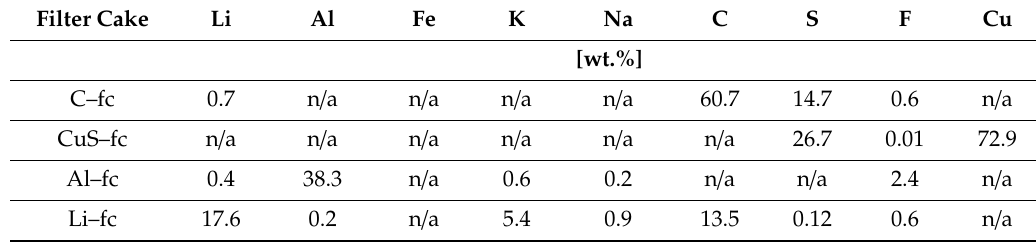
Table 10. Chemical composition of VD4 filter cakes in [wt.%]. The label “fc” indicates filter cakes. Filter Cake Li Al Fe K